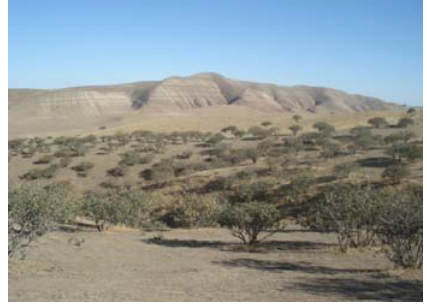
Figure 2. Overall view of the study